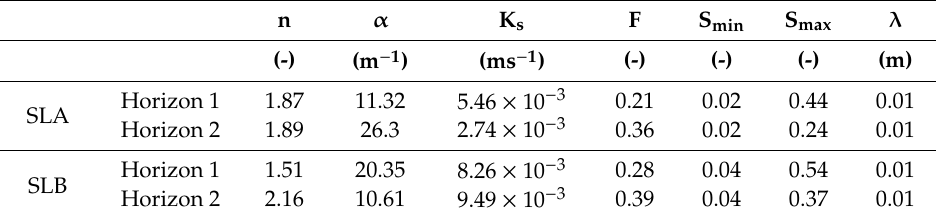
Table 4. Best set of soil hydraulic parameters obtained for sites SLA and